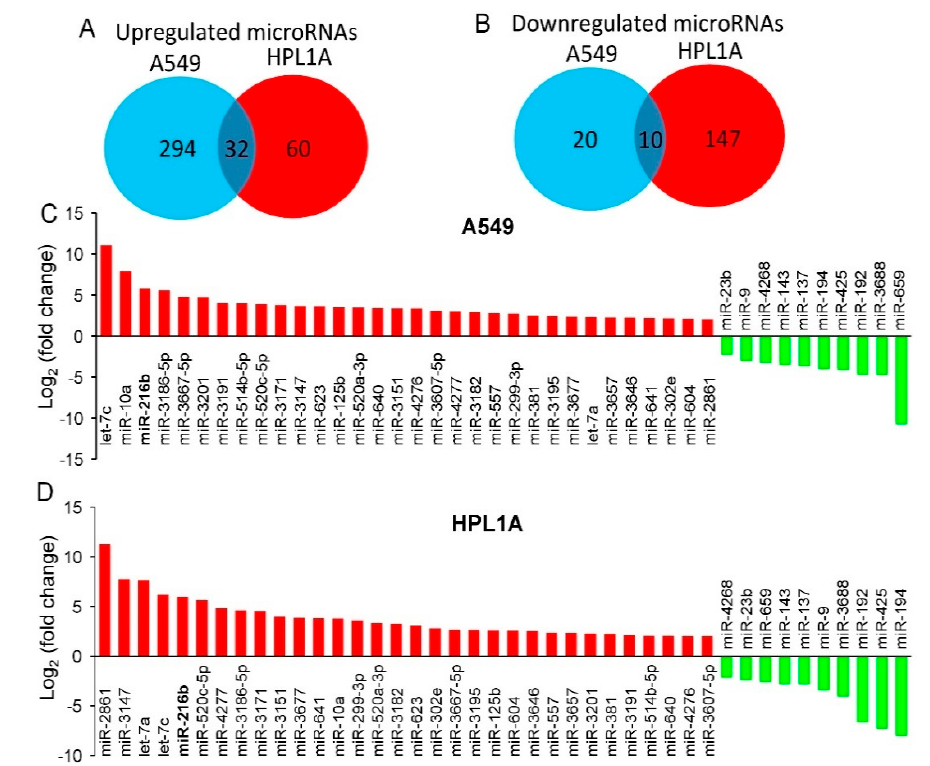
Figure 1. Identification of smoking-related miRNAs by microarray analyses. ( A , B ) Venn diagrams displaying di ff erentially regulated microRNAs that are upregulated (log2 (fold change) > 2) ( A ) or downregulated (log2 (fold change) < − 2) ( B ) in both A549 and HPL1A cells treated with CSC for 12 months. ( C , D ) Top common upregulated and downregulated miRNAs in CSC-treated A549 ( C ) and HPL1A ( D ) cells compared to DMSO-treated cells.